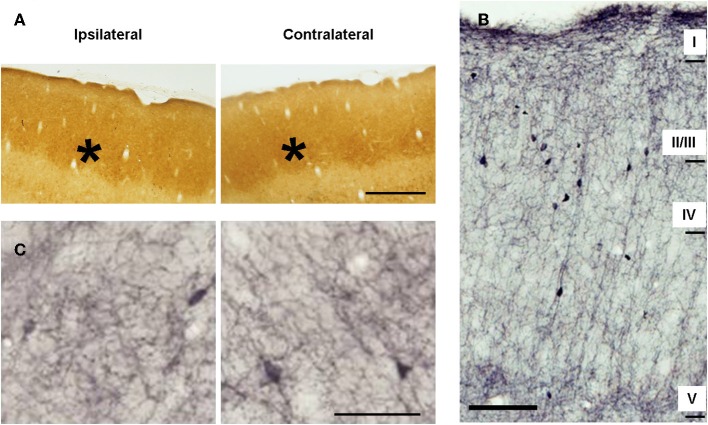
Metabolic activity and cholinergic innervation in the barrel cortices of control animals. (A) Microphotographs of horizontal sections of CyO-stained barrel cortices. Ipsilateral and contralateral (with respect to side of the peripheral manipulation) slides belong to sections from the same subject and were immunoreacted simultaneously. Barrels, marked with stars, are clearly visible in all sections. (B) Low-magnification photomicrograph showing the laminar distribution of choline acetyltransferase (ChAT)-immunopositive fibers in horizontal section from the barrel cortex. Scale bar = 100 μm. (C) Microphotographs of horizontal sections of ChAT-immunostained barrel cortices. Staining intensity is similar in the two cortices for both, metabolic and cholinergic activity. Panels (A,C) in ipsilateral hemispheres rostral is right; in contralateral hemispheres, rostral is left; lateral is top. Scale bars = 200 μm in (A) and 50 μm in (C).